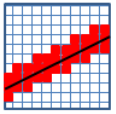
Figure 3. Epipolar line in the search window